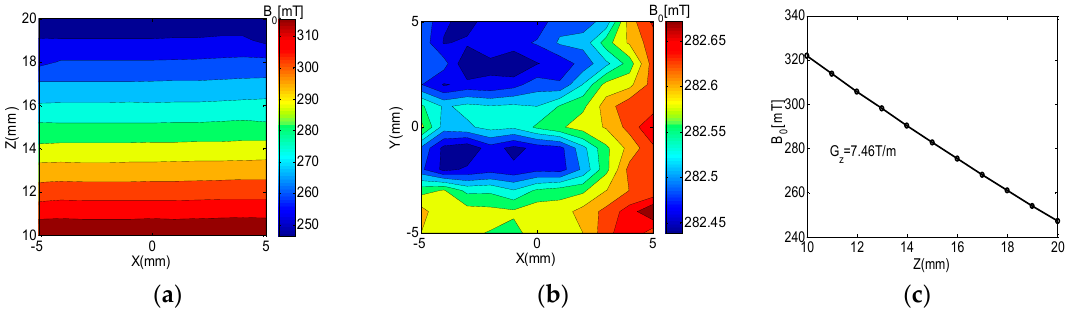
Figure 2. Measured results of the optimized magnet structure. ( a ) Measured field on the xoz plane; ( b ) The magnitude of the measured field on the xoy target plane was approximately 0.282 T; ( c ) Actual constant gradient was about 7.46 T/m points along z .